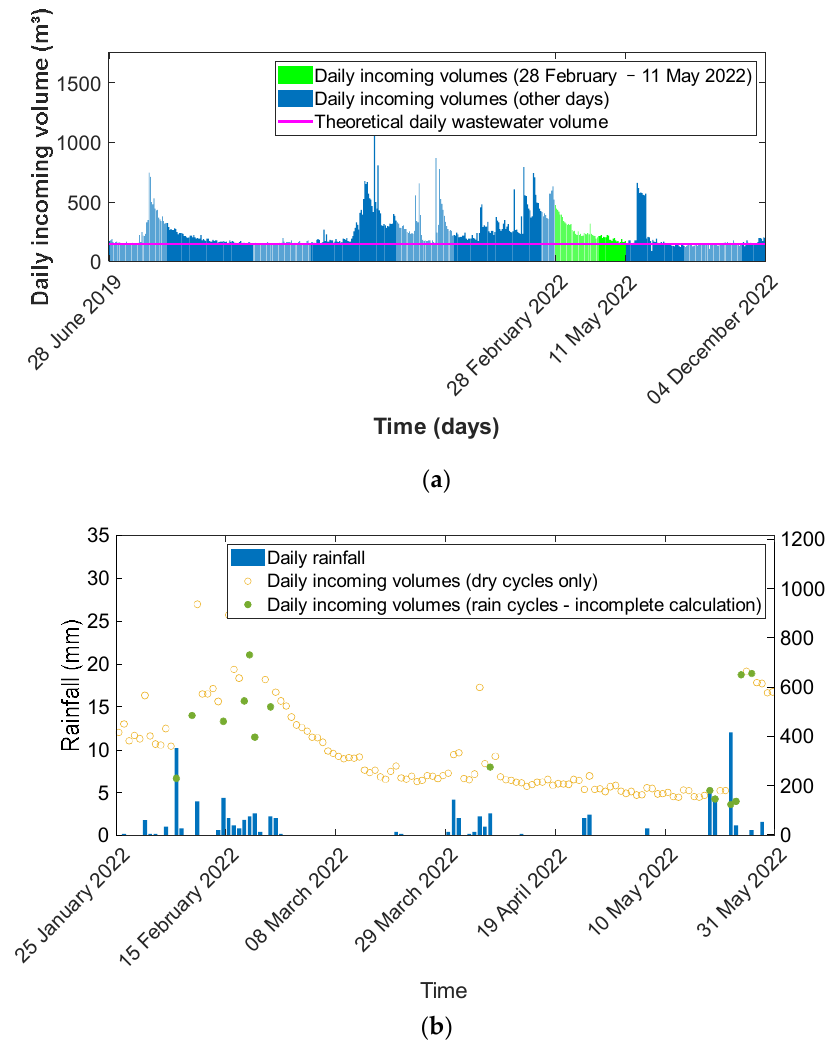
Figure 10. Overview of daily incoming volumes: ( a ) only dry weather days (top); ( b ) all days including rainfall for the selected period (bottom) (PS Zuidstraat).